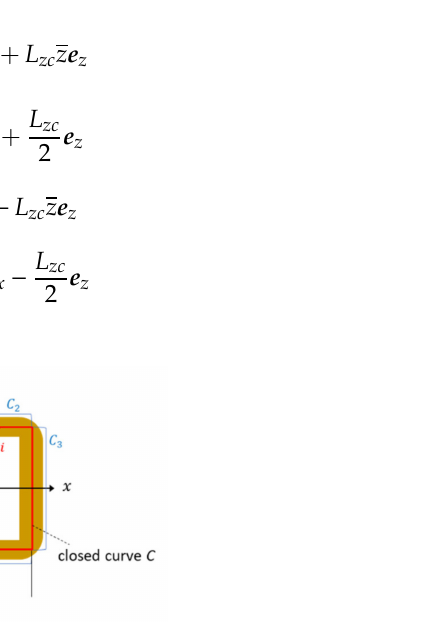
Figure 5. Rectangular closed curve C and its four edges of the levitation